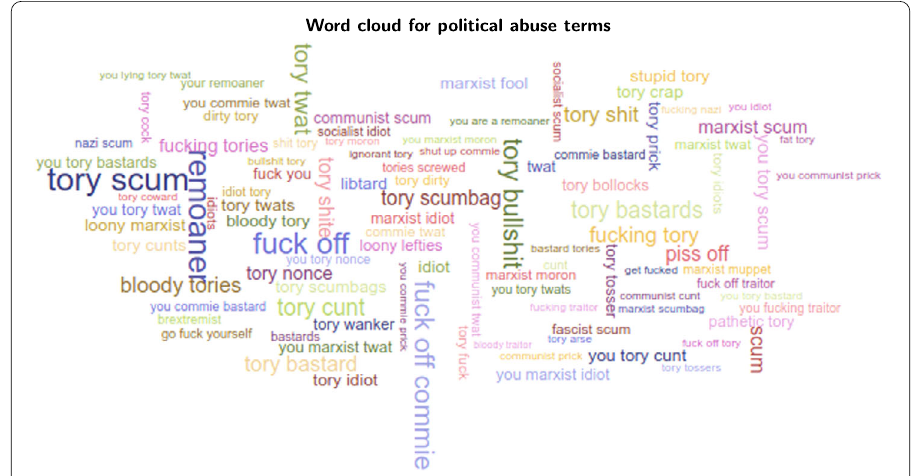
Figure 9 Word cloud for political abuse terms. Word cloud displaying the abuse terms most frequently found in tweets containing political abuse. “F**k off” appears because it commonly occurs with political